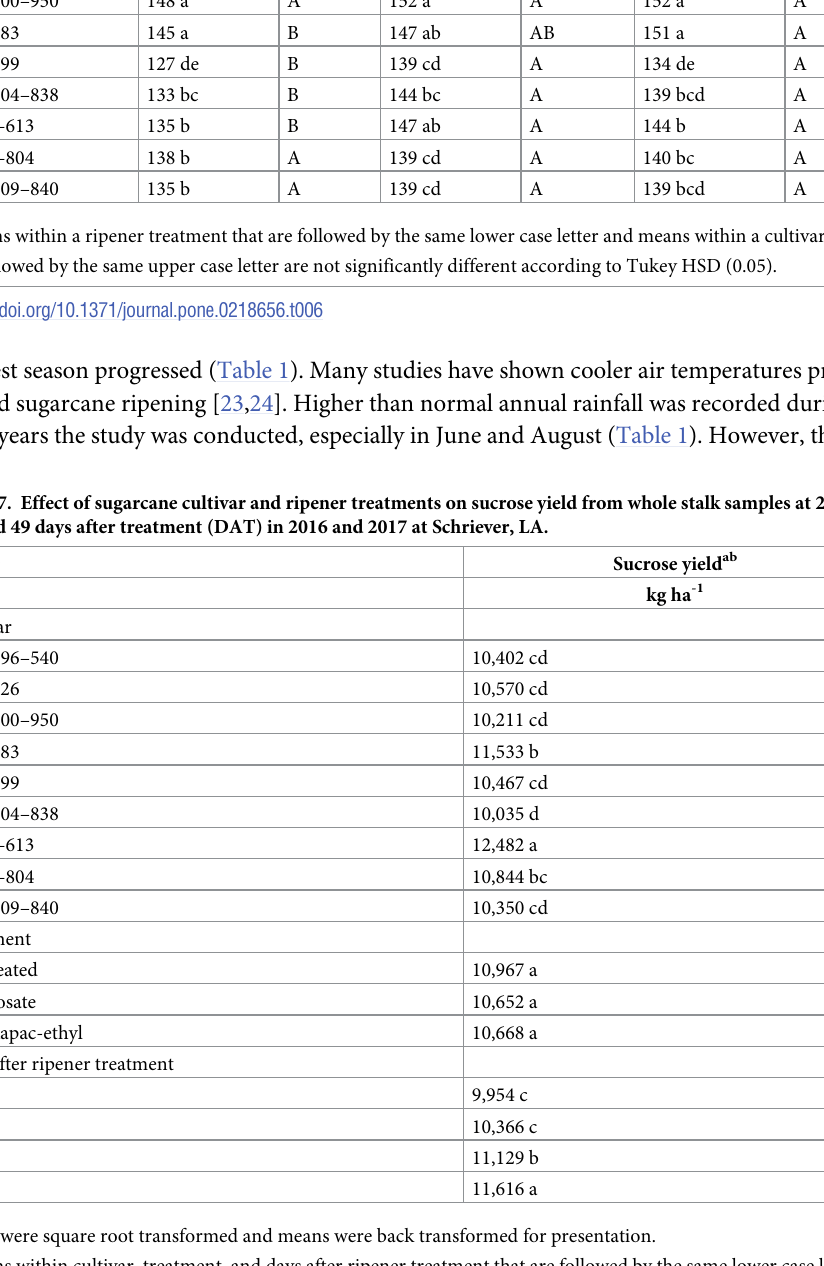
Table 6. Theoretical recoverable sucrose as affected by ripener treatment in 2016 and 2017 at Schriever, LA. Theoretical recoverable sucrose a Nontreated Glyphosate Trinexapac-ethyl _________________________________ kg Mg -1 ________________________________ Cultivar HoCP 96–540 122 e